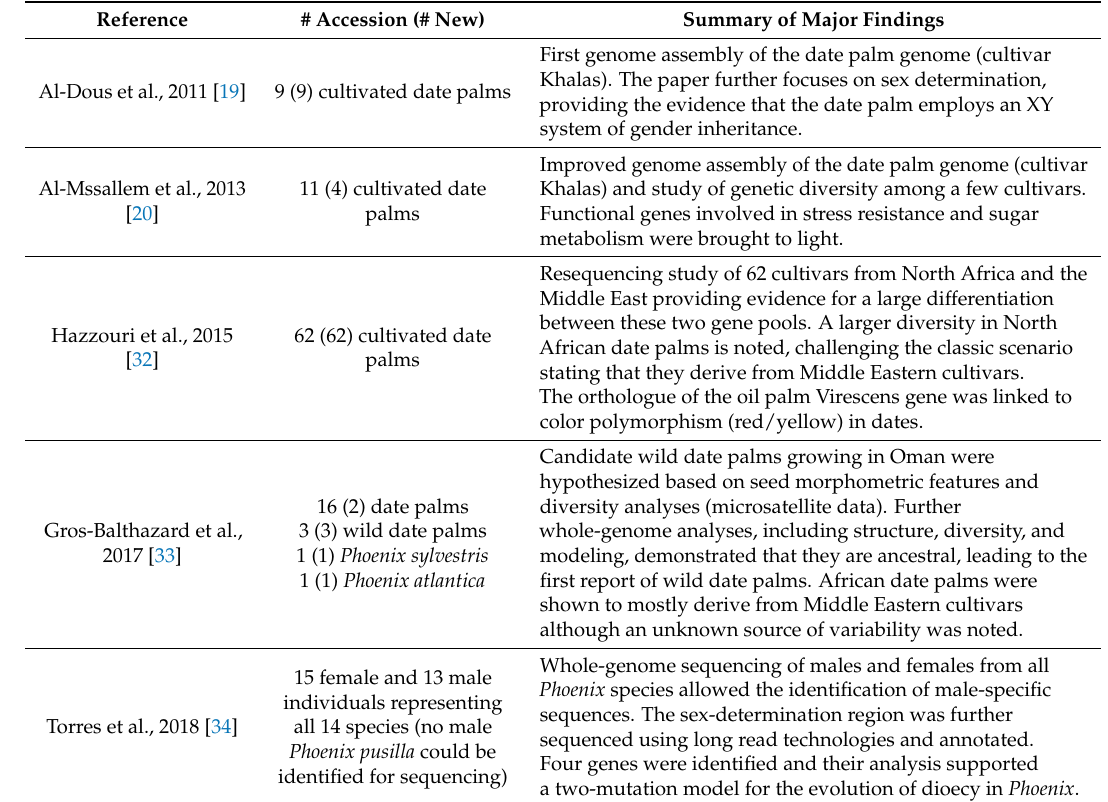
Table 2. Comprehensive list of whole-genome resequencing studies of date palms and wild relatives in September 2018. # accession is the number of Phoenix spp. individuals included while (# new) refers to the number of new sequences generated for the